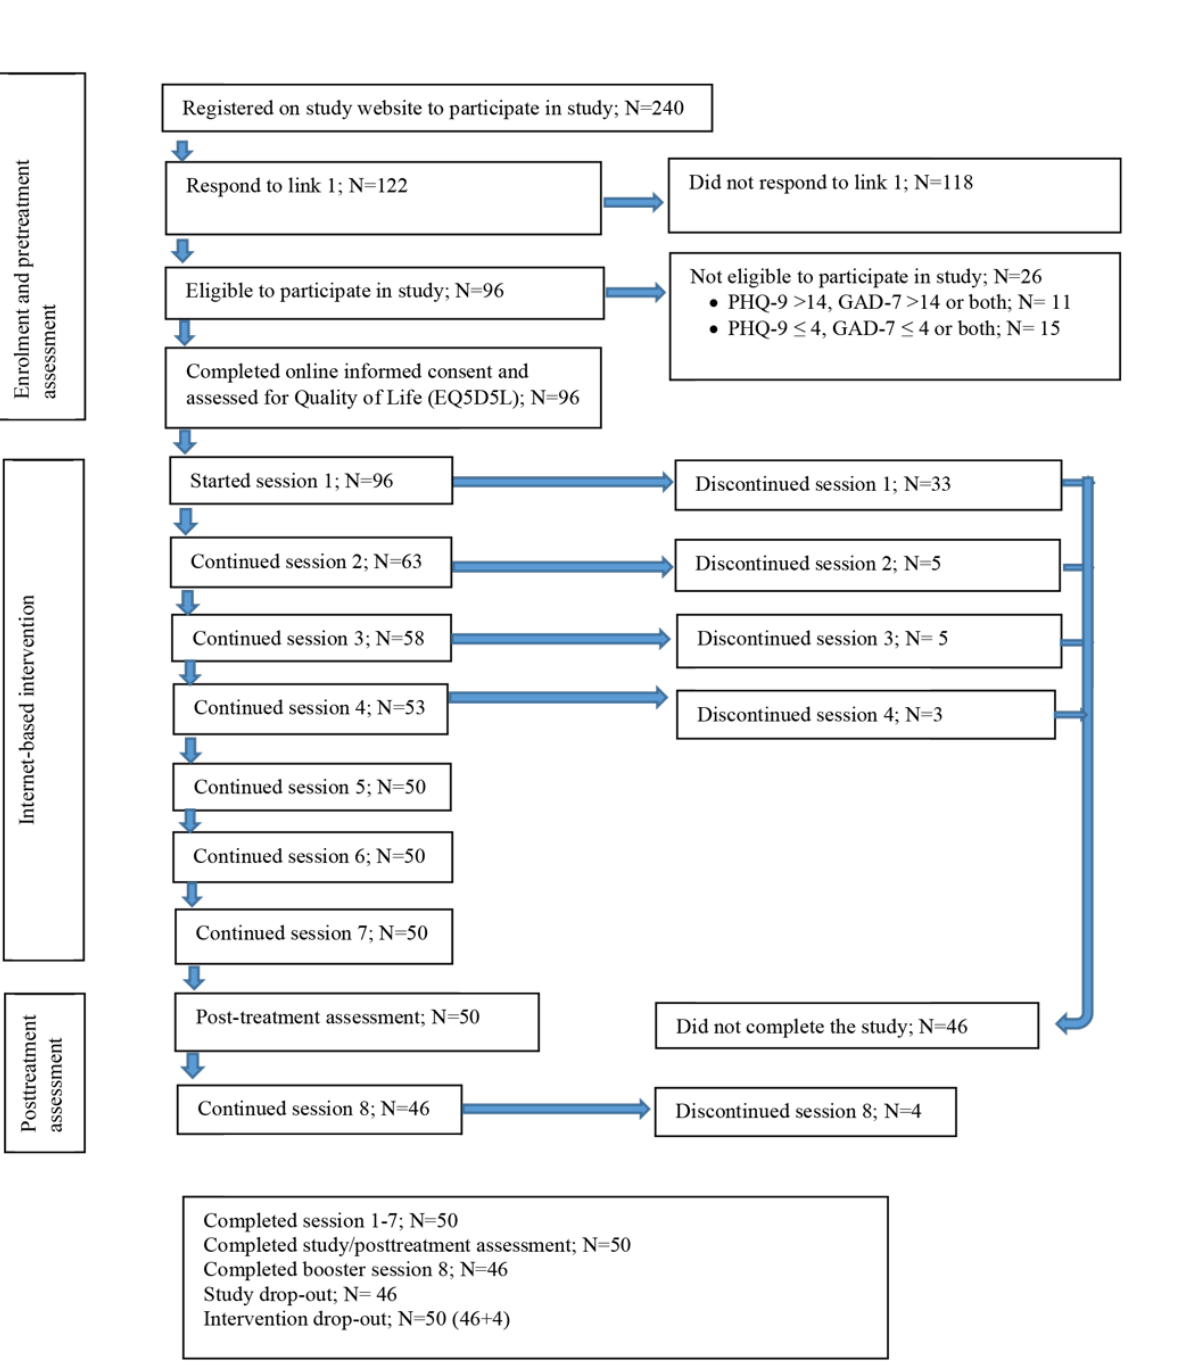
Figure 1. The flowchart of study participants.